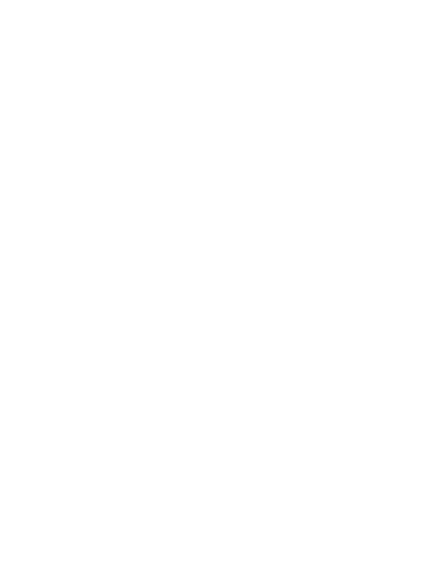
Table 1. Parameter value s for